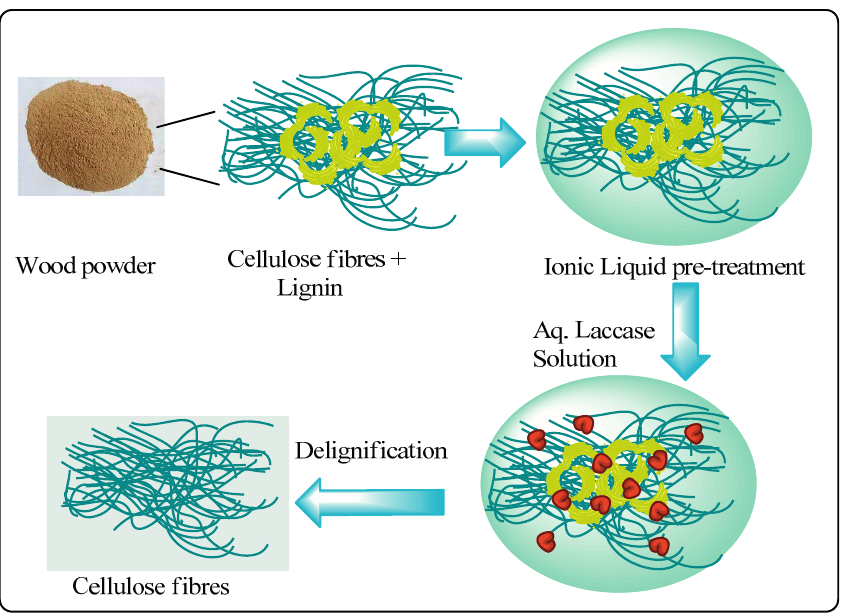
Figure 3. Delignification of woody biomass using ionic liquid and enzymes